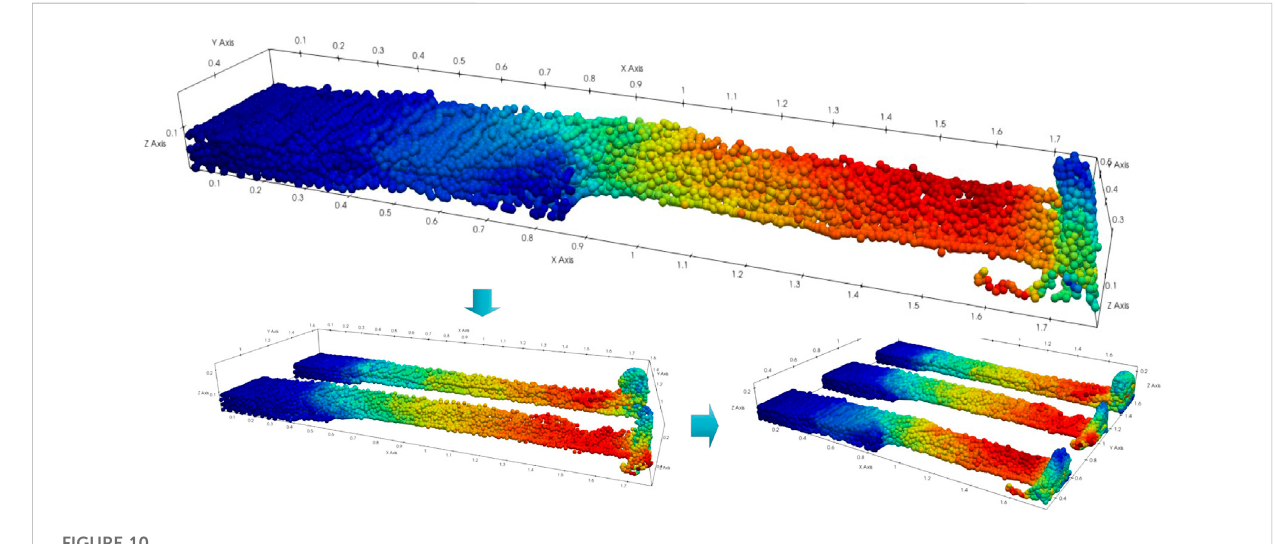
FIGURE 10 Fluid particles calculated by different processes.